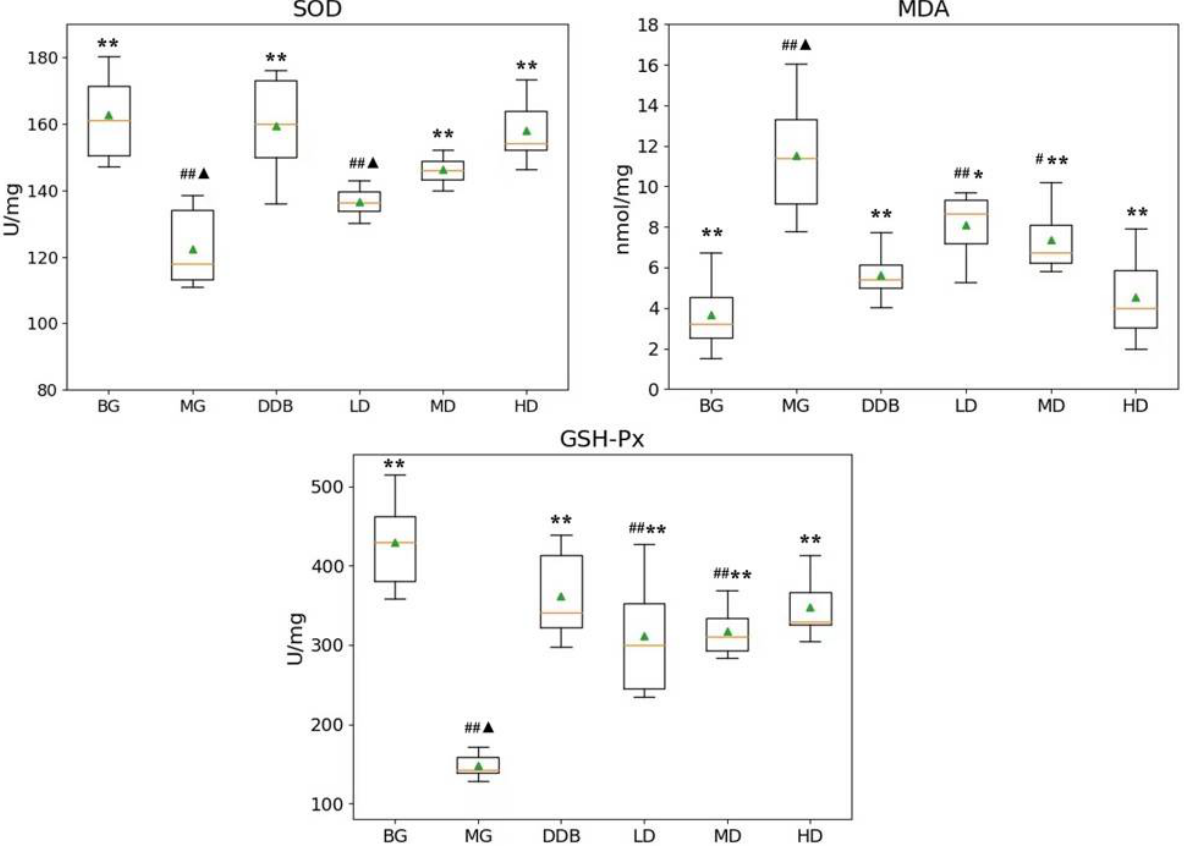
Figure 1. Effects of SBS on SOD, MDA, and GSH-Px in liver tissue. Data are presented as mean ± S.E.M. ( n = 10). Significant differences compared with the BG group were designated as # p < 0.01 and ## p < 0.05, with the MG group as * p < 0.05 and ** p < 0.01, and with the DDB groups as (cid:78) p <